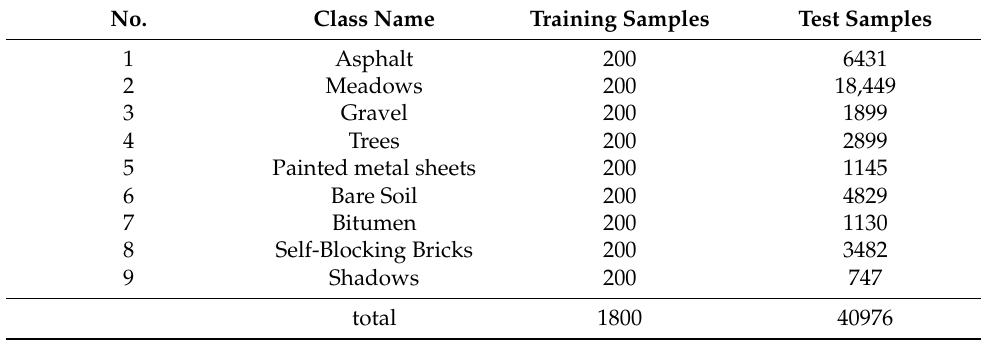
Table 1. Samples distribution for Pavia University dataset.